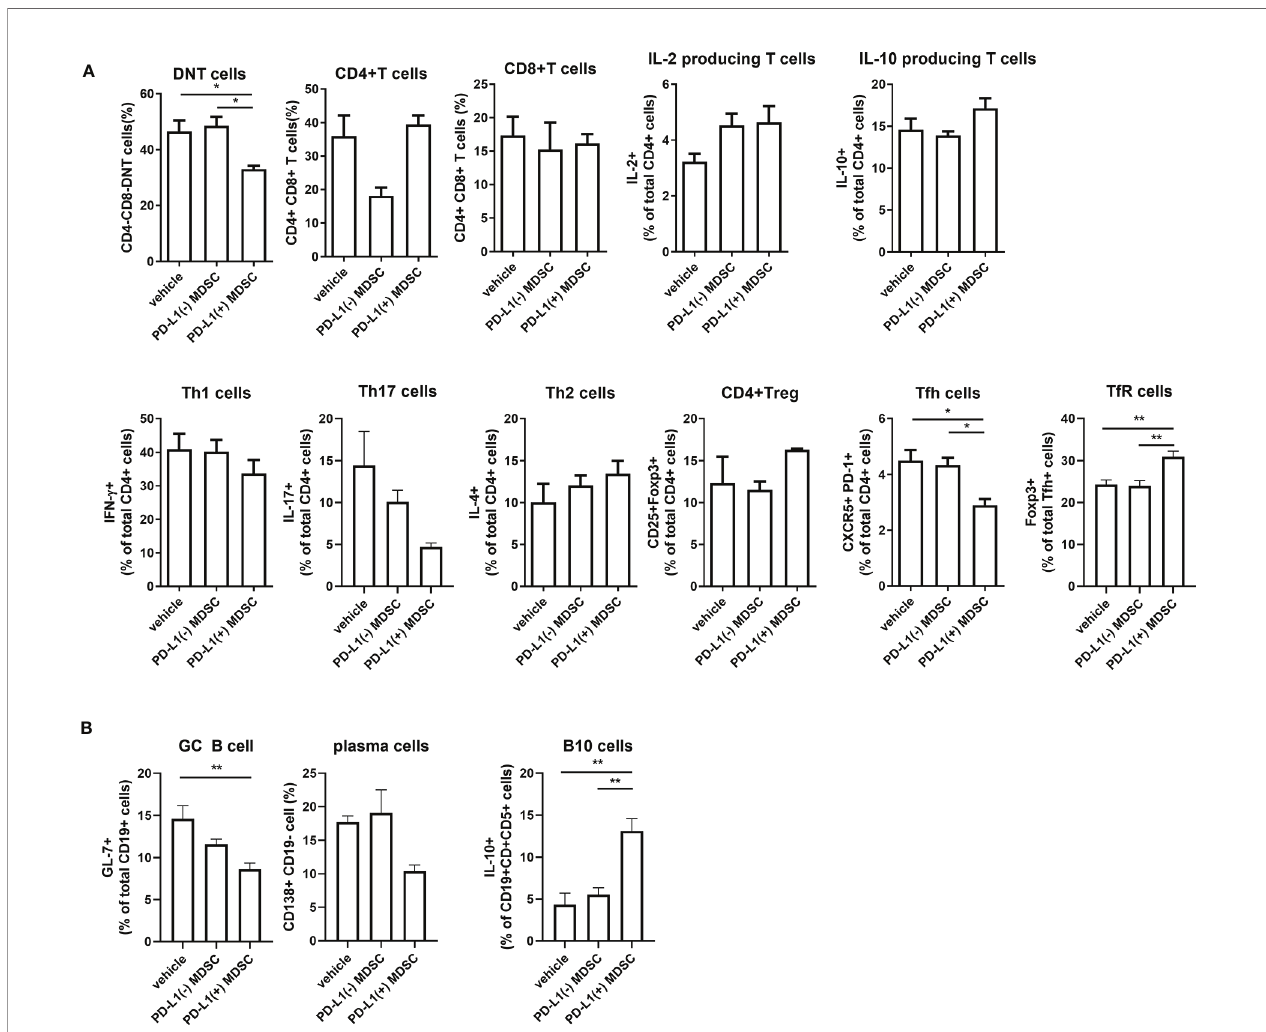
FIGURE 5 | Cell therapy with PD-L1 positive MDSCs profoundly decreases pathogenic double negative T cells (DN T cells) in spleens of MRL/ lpr mice. (A) Flow cytometric analysis shows the populations of DN T cells (CD4-CD8-CD3+ T cells), CD4+ T cells, CD8+ T cells, IL2+CD4+ T cells, CD4+IL-10+ T cells, CD4+IFN- g T cells (Th1 cells), CD4+IL-17+ T cells (Th17 cells), CD4+IL-4+ T cells (Th2 cells), CD4+CD25+FOXP3+ cells (Treg cells), CD4+CXCR5+PD-1+ T cells (Tfh cells) and CD4+CXCR5+PD-1+ Foxp3+(TFR cells) in spleen tissues from MRL/ lpr mice treated with PD-L1 positive and/or negative MDSCs obtained from MRL/MpJ mice. Relative bar charts are shown. (B) Flow cytometric analysis shows the populations of CD19+GL7+ cells (GC B cells), CD19-CD138+ cells (plasma cells) and CD19+ CD1d+CD5+IL-10+ cells (IL-10 producing B10 cells) in spleen tissues from MRL/ lpr mice. Relative bar charts are shown. Data are expressed as the mean ± SEM. Data are representative of three independent experiments [* P < 0.05, ** P < 0.01 versus control